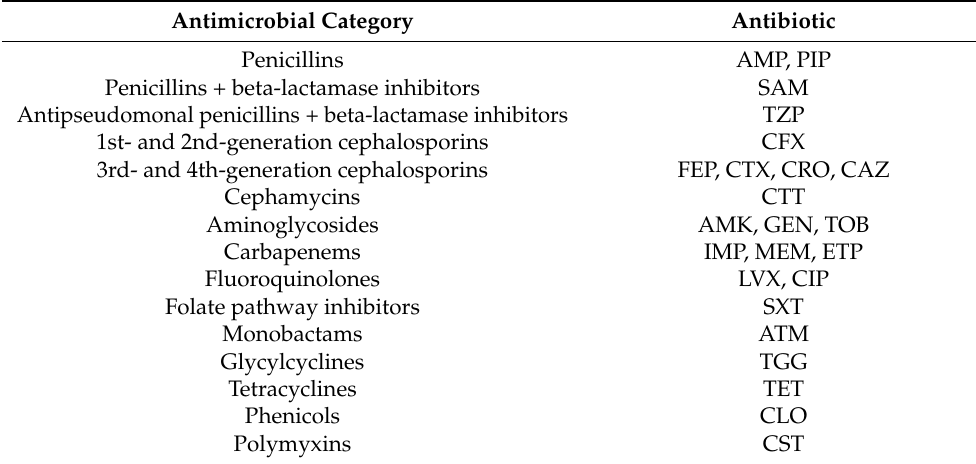
Table 1. Antibiotics tested against MDR UPEC. Antimicrobial Category Antibiotic